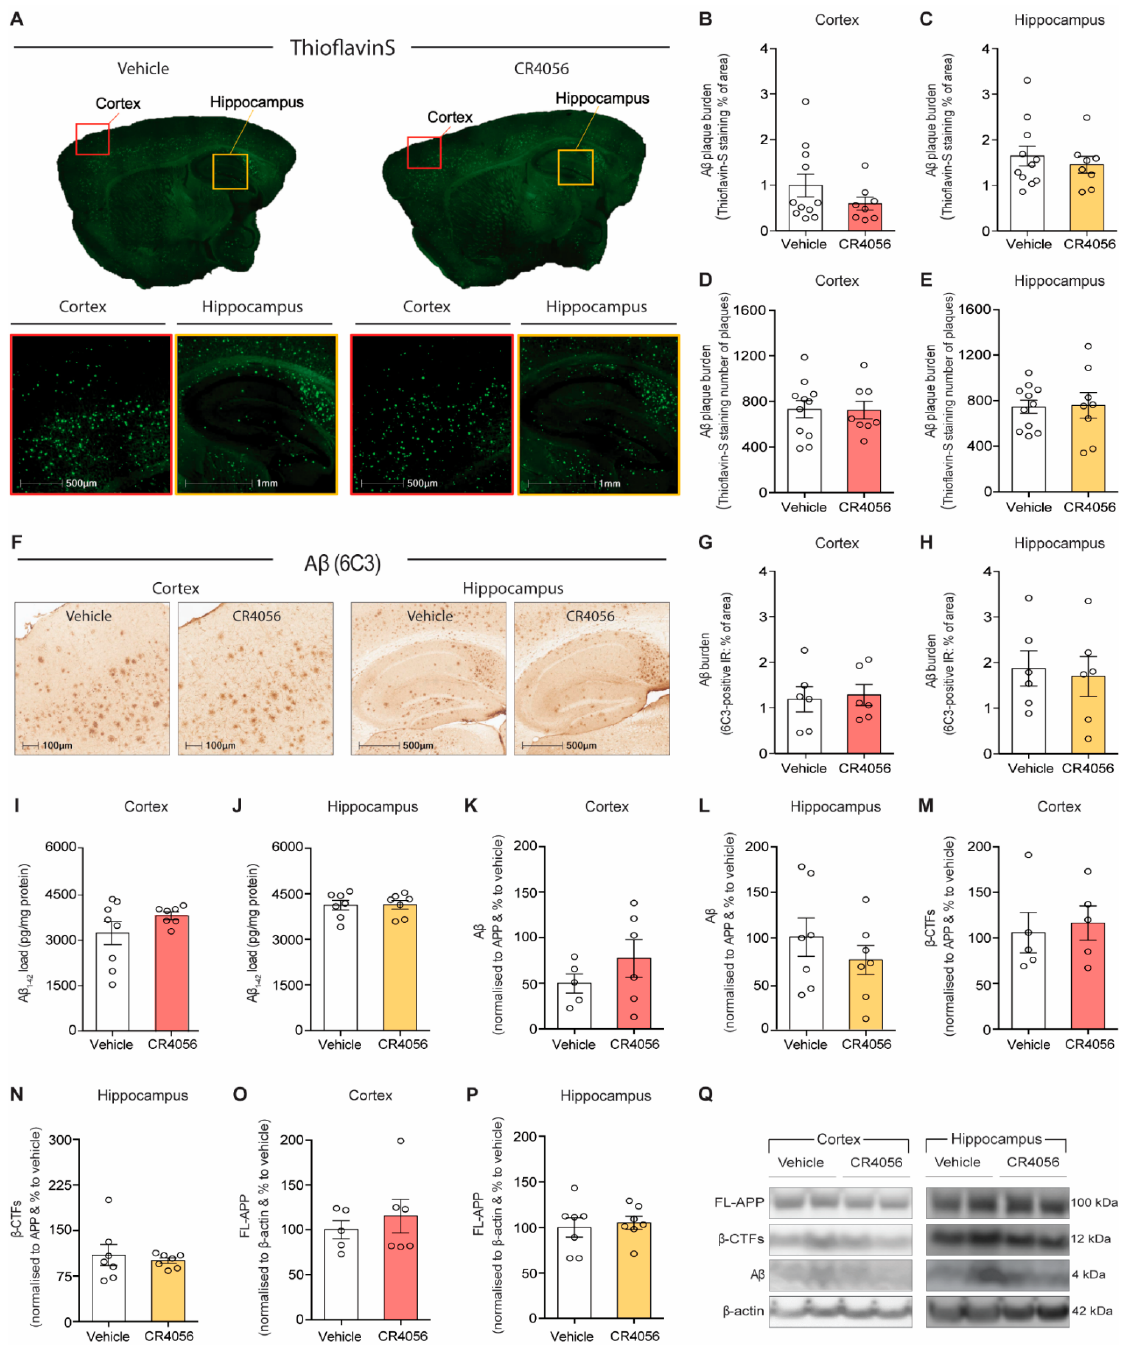
Figure 3. Sub-chronic treatment with CR4056 does not affect Amyloid- β (A β ) generation and deposition in the cortex and hippocampus of 5xFAD mice. ( A ) Representative images of Thioflavin S staining in sections of 6-month-old 5xFAD mice after treatment with Vehicle or CR4056, respectively. ( B , C ) Quantification of percentage of area covered with A β plaques by Thioflavin S staining in cortex and hippocampus ( n = 8–11 per group). ( D , E ) Measurement of number of A β plaques by Thioflavin S staining in cortex and hippocampus ( n = 8–11 per group). ( F ) Representative images of anti-A β (MOAB-2) immunohistochemistry in cortex and hippocampus of 6-month-old 5xFAD treated with Vehicle or CR4056. ( G , H ) Quantification of A β load as percentage of area